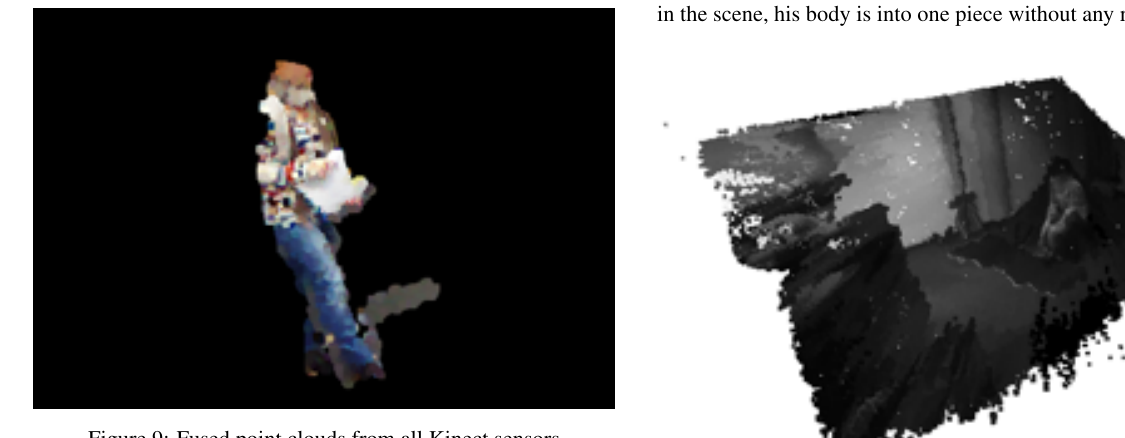
Figure 9: Fused point clouds from all Kinect sensors